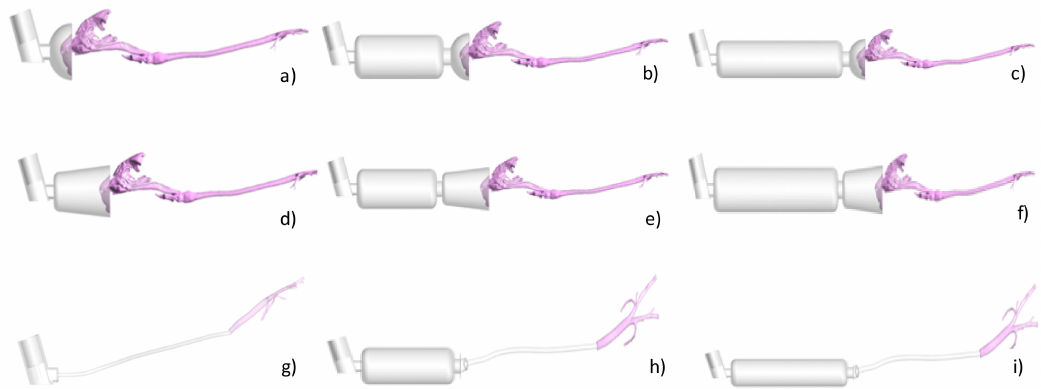
Figure 1. Pressurized metered-dose inhaler (pMDI) and device models for computational fluid dynamics simulations: ( a ) pMDI connected to a spherical preoxygenation mask, ( b ) pMDI connected to a 10 cm spacer and a spherical preoxygena- tion mask, ( c ) pMDI connected to a 20 cm spacer and a spherical preoxygenation mask, ( d ) pMDI connected to a conical preoxygenation mask, ( e ) pMDI connected to a 10 cm spacer and a conical preoxygenation mask, ( f ) pMDI connected to a 20 cm spacer and a conical preoxygenation mask, ( g ) endotracheal tube (ETT) 4 mm ID, trachea, and main bronchus, ( h ) pMDI connected to a 10 cm spacer and an ETT 4 mm ID, trachea, and main bronchus, ( i ) pMDI connected to a 20 cm spacer and an ETT 4 mm ID, trachea, and main bronchus. Computational CT-based models with Ansys: a–f, non-intubated cat model; g–i, intubated